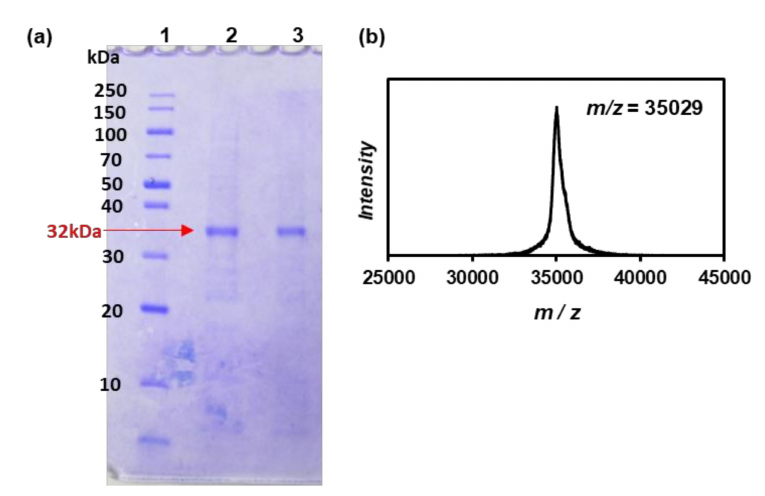
Figure 6. ( a ) SDS-PAGE of His-tagged apo-HRP (Lane 2: 0.4 mg / mL, Lane 3: 0.2 mg / mL) and ( b ) MALDI-TOF-MS of His-tagged HRP.